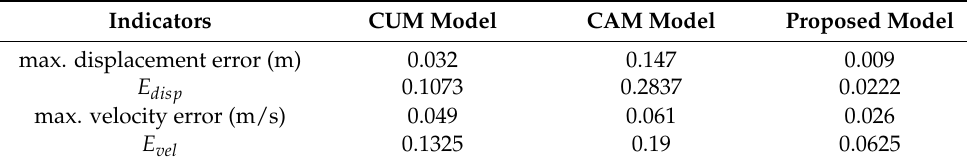
Table 2. Summary of quality indicators for numerical models